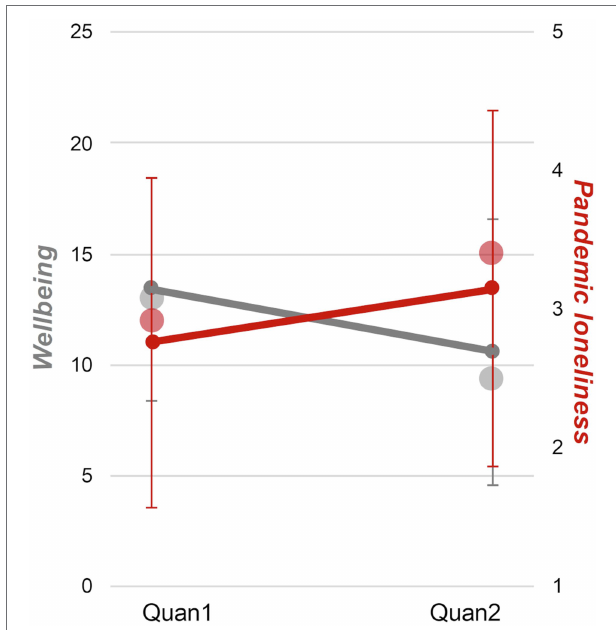
FIGURE 2 | Pandemic loneliness and wellbeing during different lockdowns. Line-diagrams indicate means and standard deviations of the repeated measure sample ( N = 67), dots indicate means of the whole sample at each lockdown (Quan1 N = 334, Quan2 N =